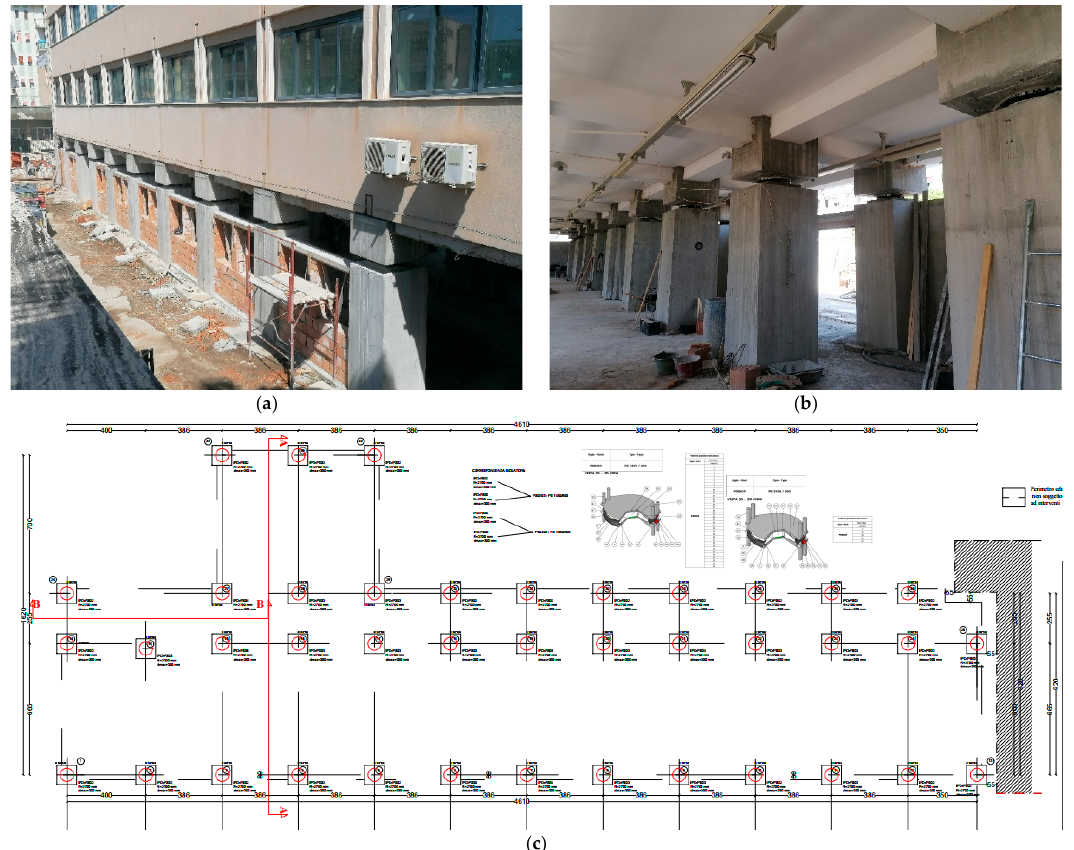
Figure 12. In-field installation of seismic devices (40 in total): ( a ) external view and ( b ) internal view, with ( c ) detailed plan view from technical drawings (dimensions in cm).